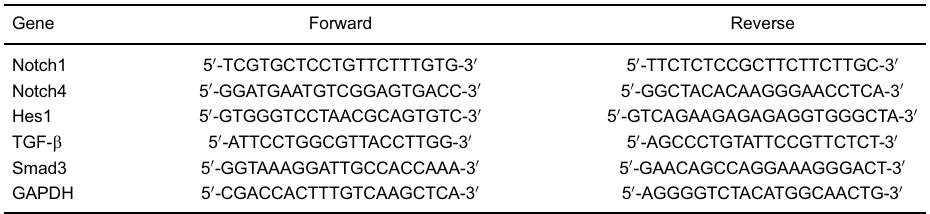
Table 1. Primers used in quantitative reverse transcription polymerase chain